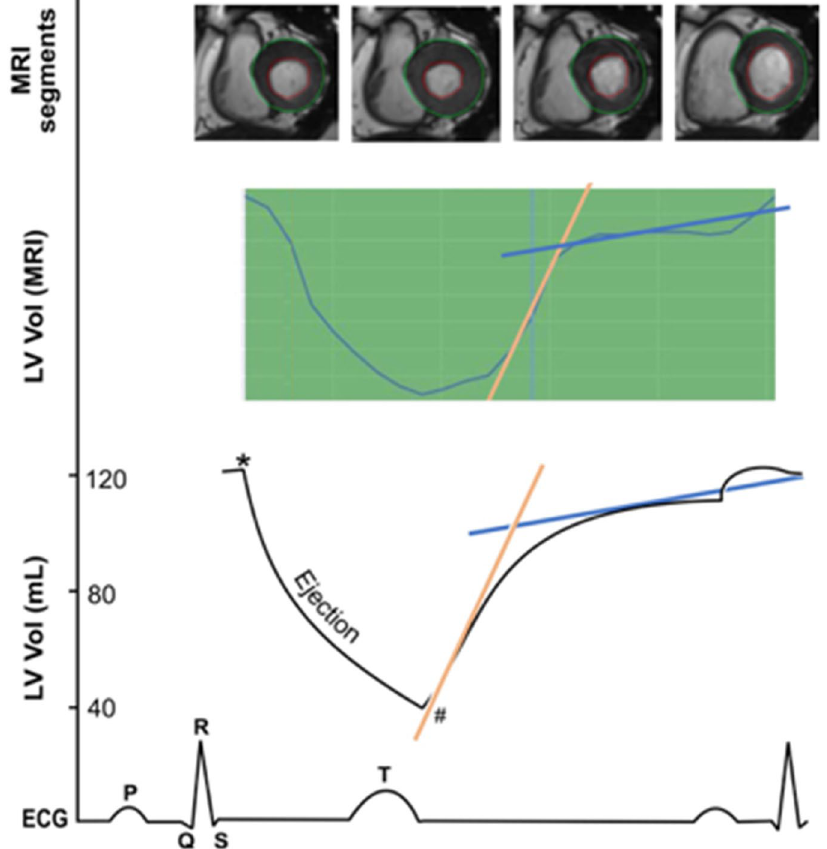
Figure 1. Early and late diastolic filling rate of the left ventricle (slope). In ECG-triggered cine MRI, the filling rates were measured during diastole and assessed by pyHeart, displaying left ventricle (LV) volume versus time curve (middlebox). Example for segmentation of LV in 2-chamber short-axis views above. * = LV end-diastolic volume, # = LV end-systolic volume, yellow line = early diastolic filling rate, blue line = late diastolic filling